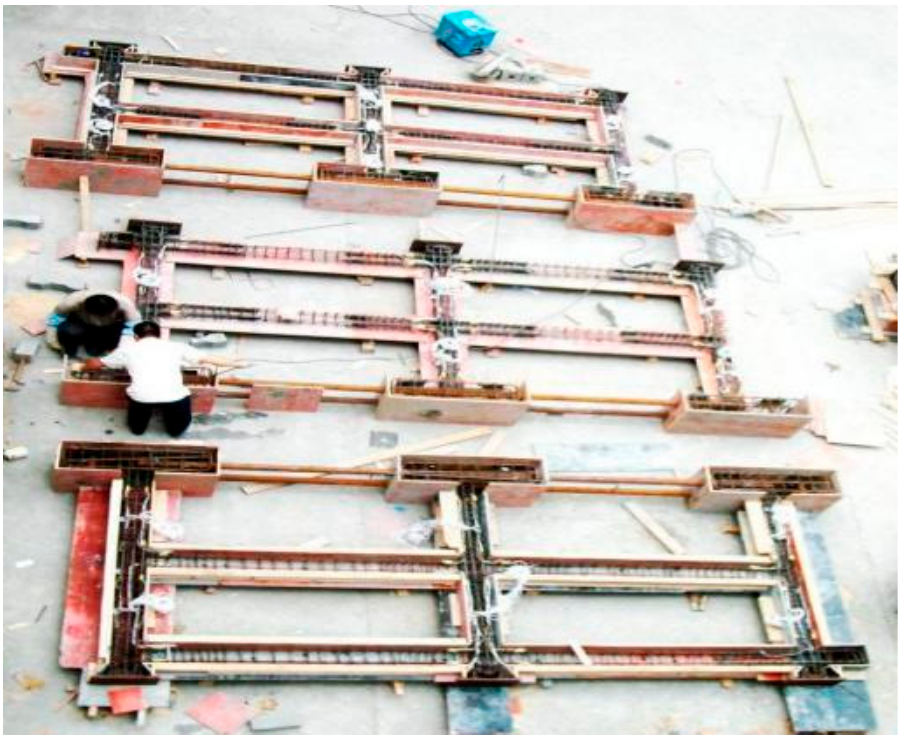
Figure 2. Production plans of the frameworks.